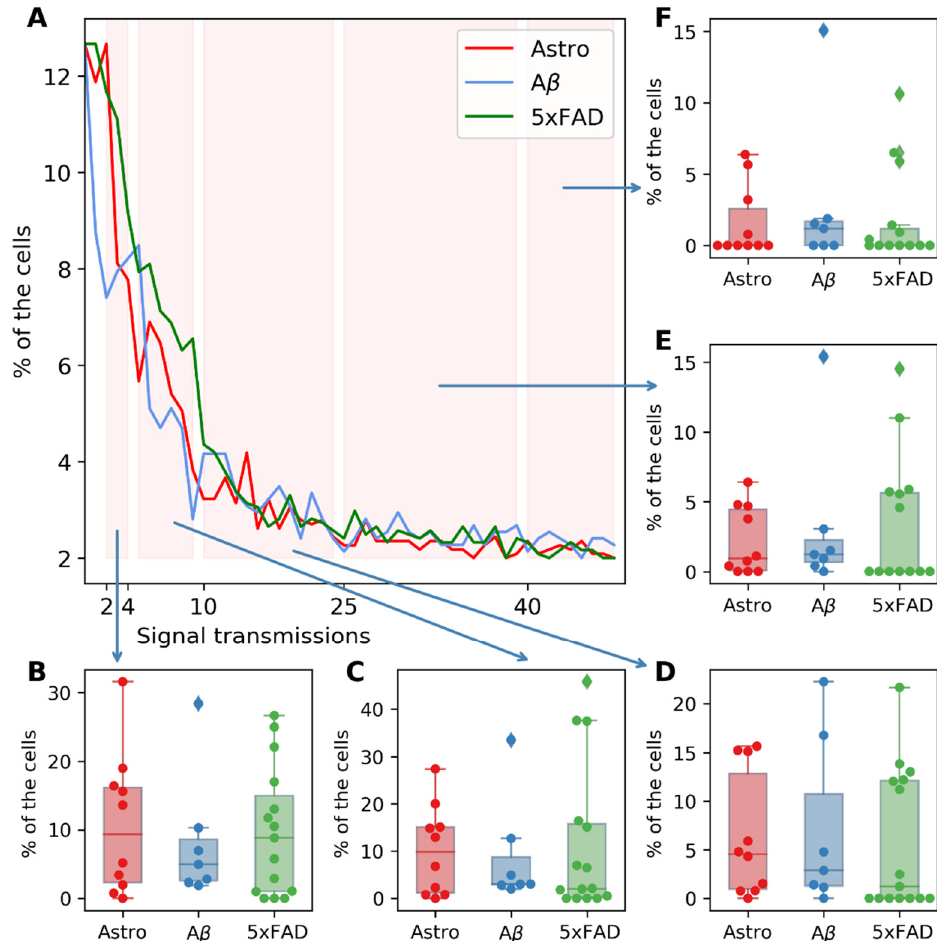
Figure 7. ( A ) Group histograms of cultures of intact astrocytes (red), astrocytes in the pharmacological modeling of AD (blue), and astrocytes obtained from transgenic animals (green). ( B ) Percentage of cells with 2 to 4 transmissions. ( C ) Percentage of cells with 5 to 10 transmissions. ( D ) Percentage of cells with 11 to 24 transmissions. ( E ) Percentage of cells with 25 to 40 transmissions. ( F ) Percentage of cells with more than 40 transmissions.